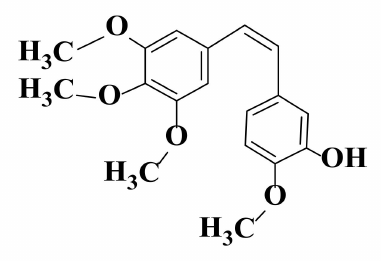
Figure 7. Combrestatin